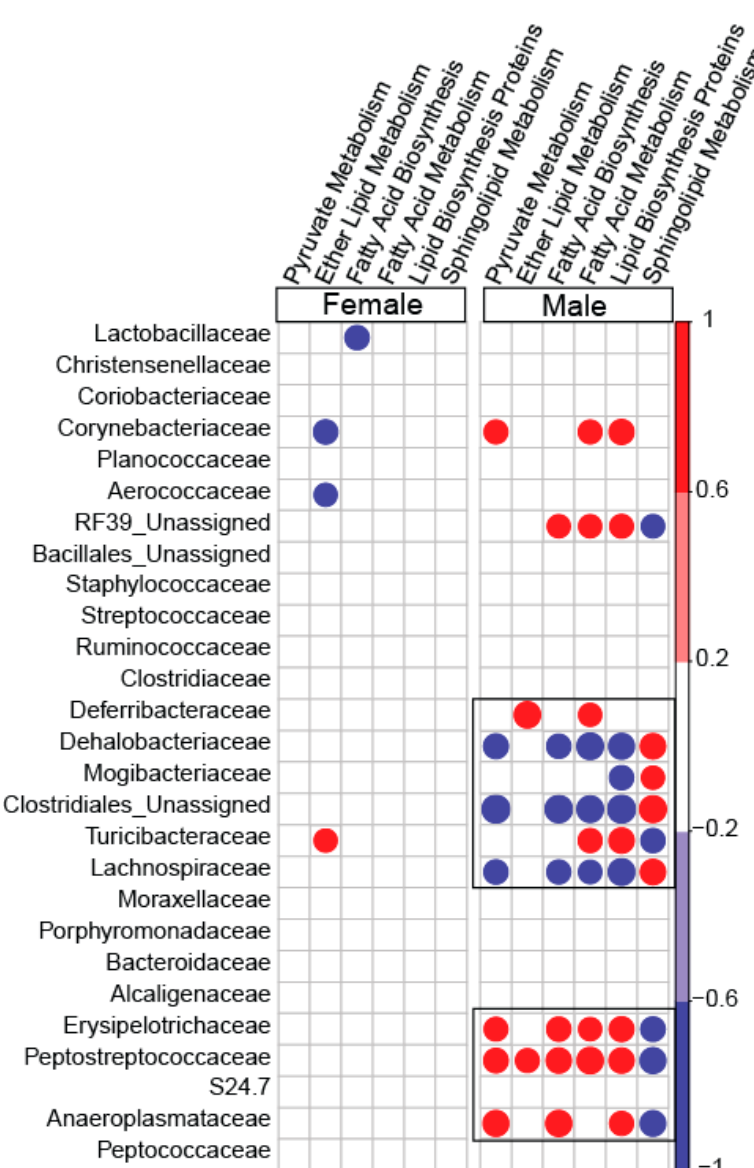
Figure 6. Spearman correlations of specific metabolic pathways predicted from microbial genomes, with the operational taxonomical unit (OTU) abundance of families. Pathways such as lipid metabolism, fatty acid metabolism, lipid biosynthesis, etc. and their association with OTU abundances at family-level taxa are shown. The color red denotes a positive association, whereas the color blue denotes negative correlations; only statistically significant correlations are depicted. The color gradient represents the degree of